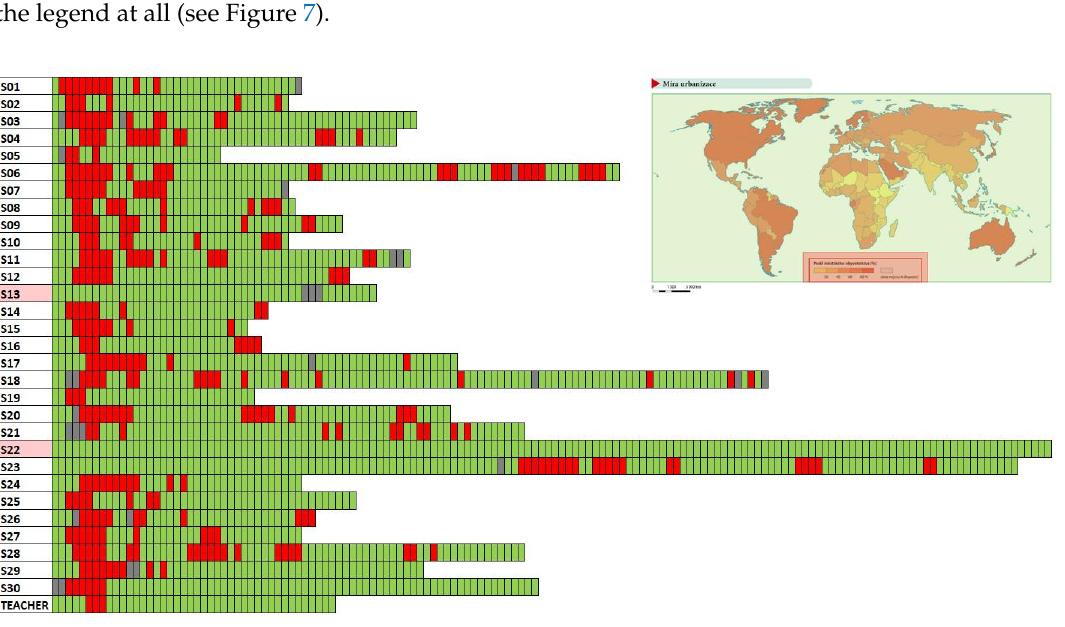
Figure 7 . Sequence chart for Task02 showing the distribution of participants’ fixations in the map field (green) and legend (red). Grey represents fixations out of the AOI.